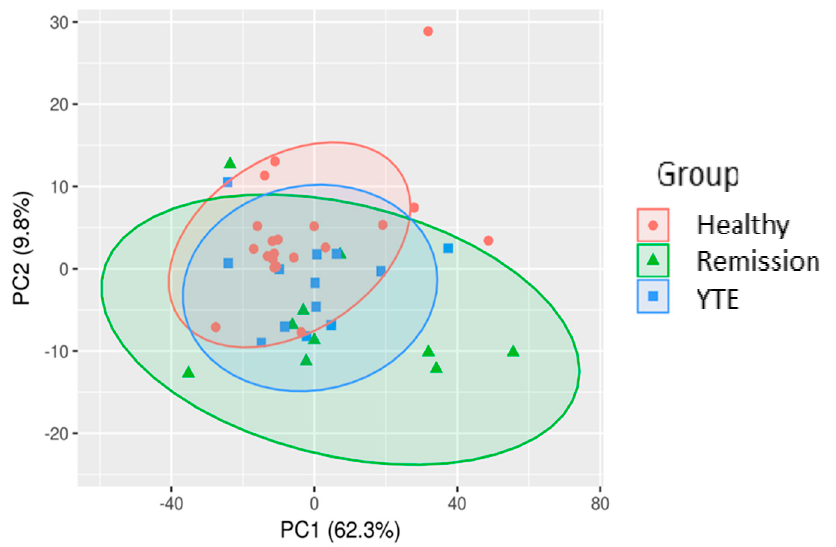
Figure 1. Principal component analysis (PCA) score plot of the first principal component (PC1) and second principal component (PC2) of plasma metabolite data from healthy controls, dogs with YTE, and dogs with YTE in clinical remission. The amount of variance in percent accounted for by each PC is included in brackets. Ellipses represent the 95% confidence interval of metabolite profiles for each